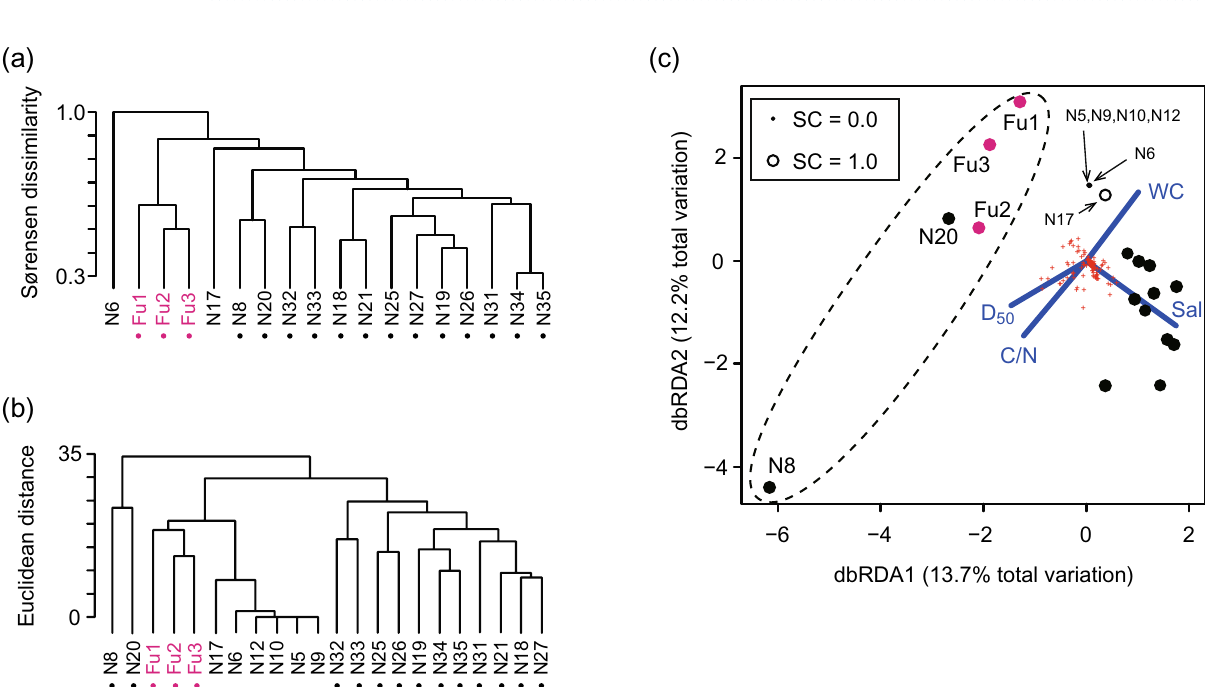
Figure 4. Community structure in Nagoya Port. Panels are the same as in Fig. 3. See Fig. 3 for the meanings of dots and circles in each panel. Magenta circles indicate observations from the Fujimae intertidal